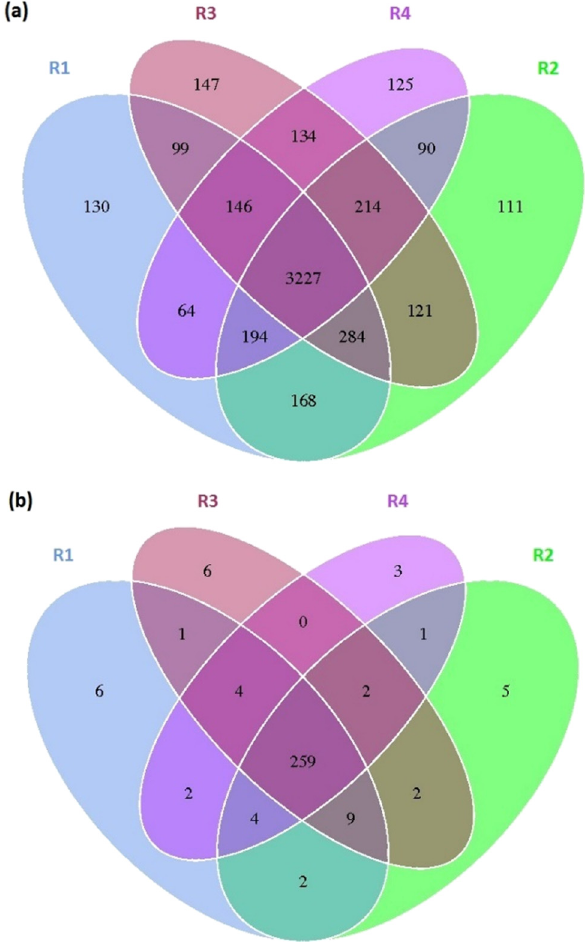
Figure 6: The Venn diagram based on the cluster analysis results of bacterial ( a ) and archaeal ( b ) OTUs in the stable phase in the anaerobic digestion of cattle manure at sub - mesophilic